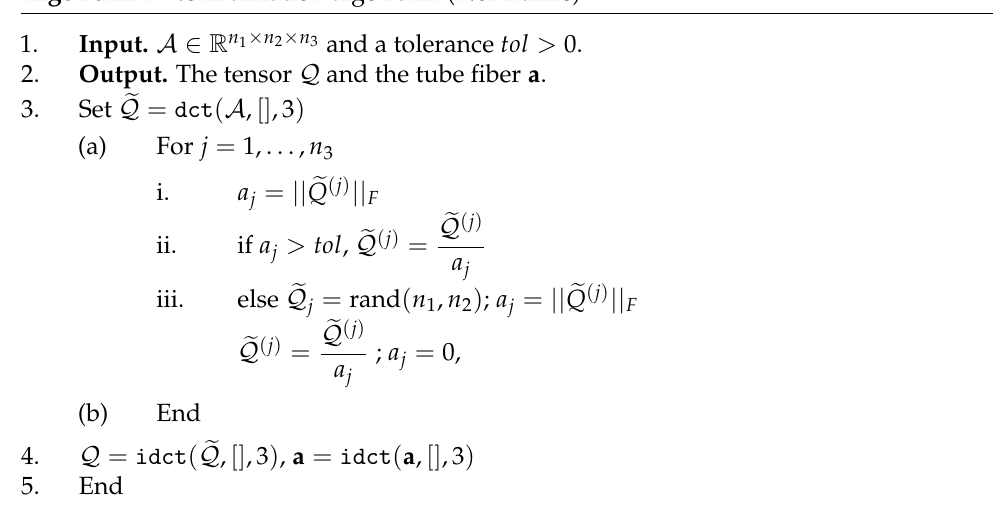
Algorithm 4 Normalization algorithm (Normalize).